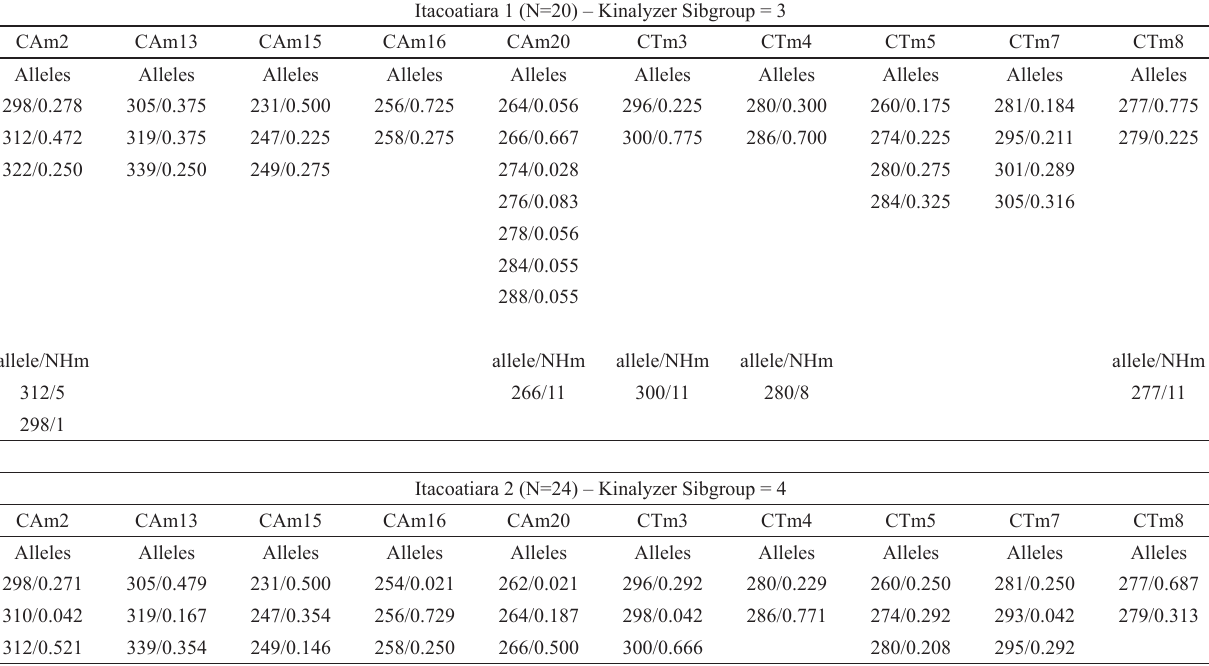
Table 3. Alleles frequencies (allele size/frequency) and number of homozygotes (allele size/number of homozygote individuals) observed in each brood of Arapaima gigas . The number of sib-groups inferred in Kinalyzer is also listed for each brood. N = number of offspring. NHm = number of homozygote